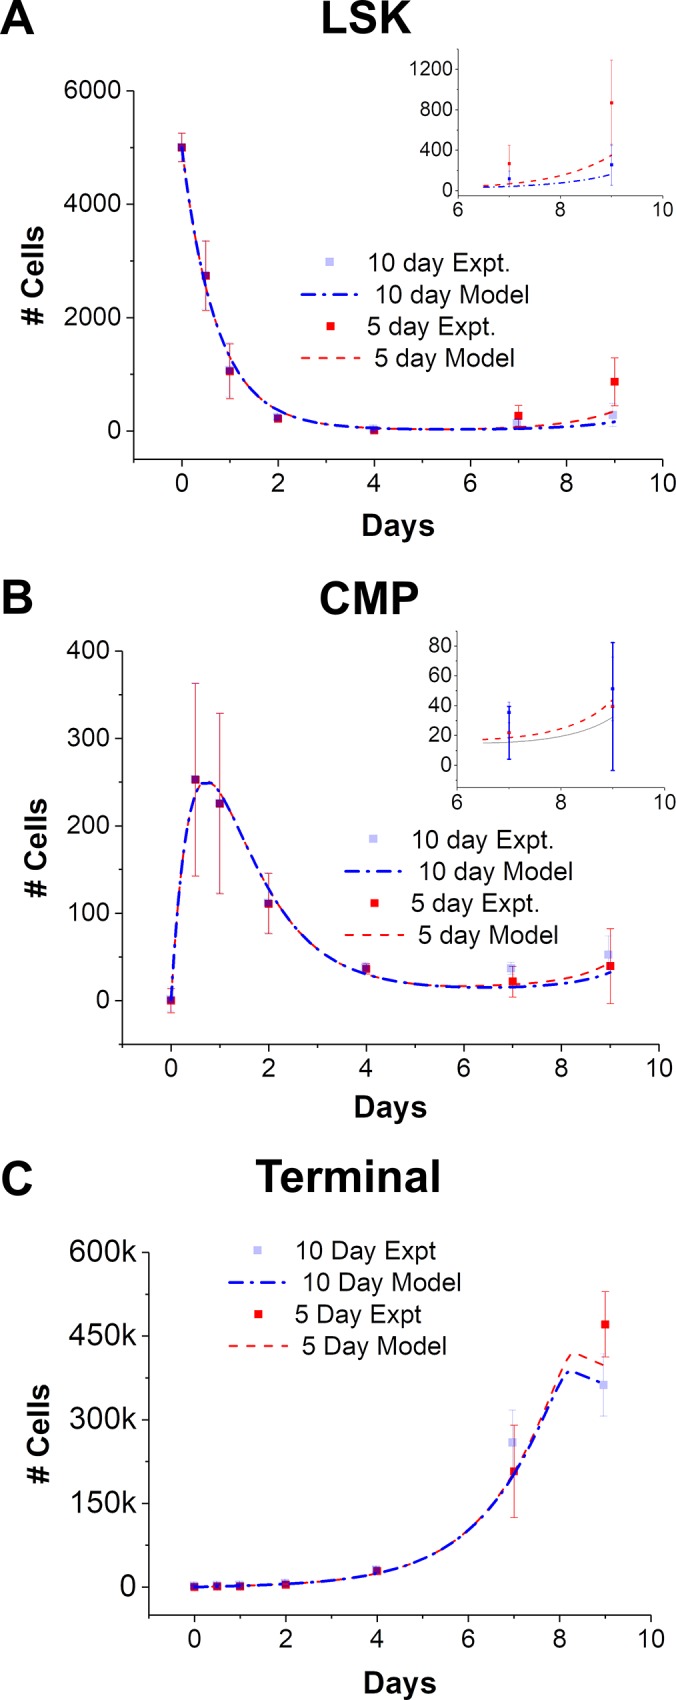
Model fit and predictions for intermediate media exchange frequencies.(A—C) Undisturbed culture conditions over the 9 day period (denoted as 10 day), led to a drop in all cell populations as compared to the 2-day media exchange. Model parameters were optimized to obtain a high degree of correlation with experimental data simply by changing media frequency change in the model to 10 days. The model was able to predict the system response to a 5-day media exchange for all the 3 cell populations, without any parameter optimization. Subtle differences in cell numbers were captured over long term culture. Inset: a close up of the model and data fit between days 7–9. Error bars represent standard deviation.